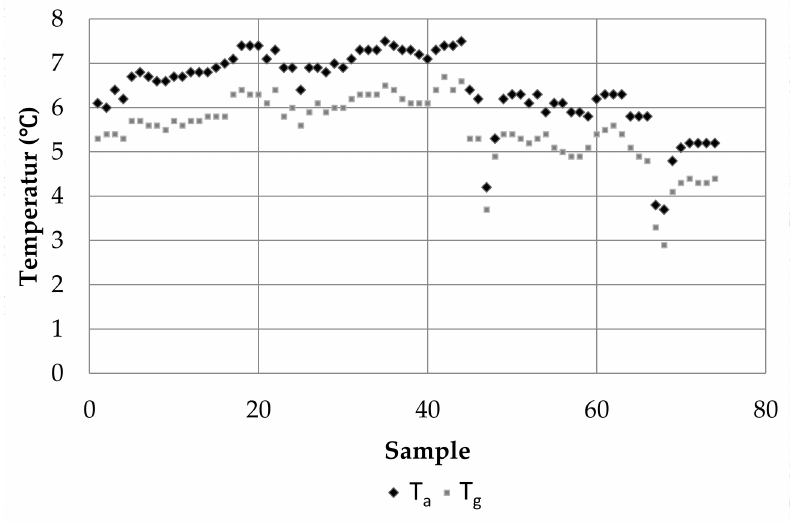
Figure 5. Comparison between globe temperature (T g ) and air temperatures (T a ).